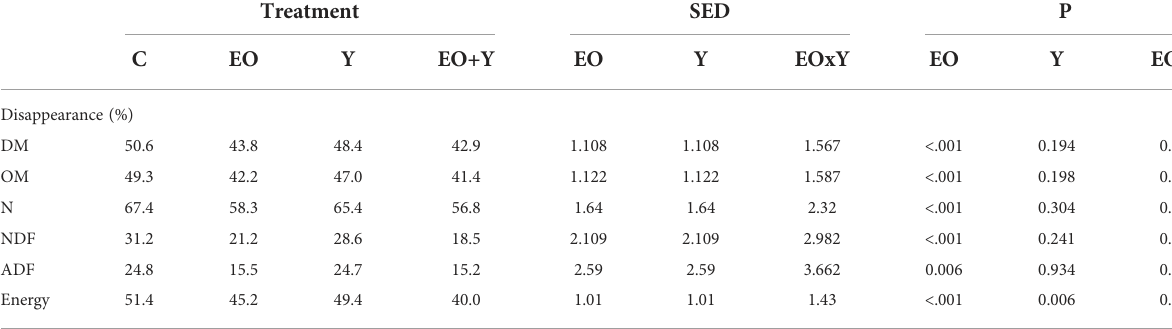
TABLE 1 Effect of supplementing a control diet (C) with oregano oil (EO), yeast (Y) or a combination of both (EO+Y) on feed and energy disappearance in the RUSITEC system.